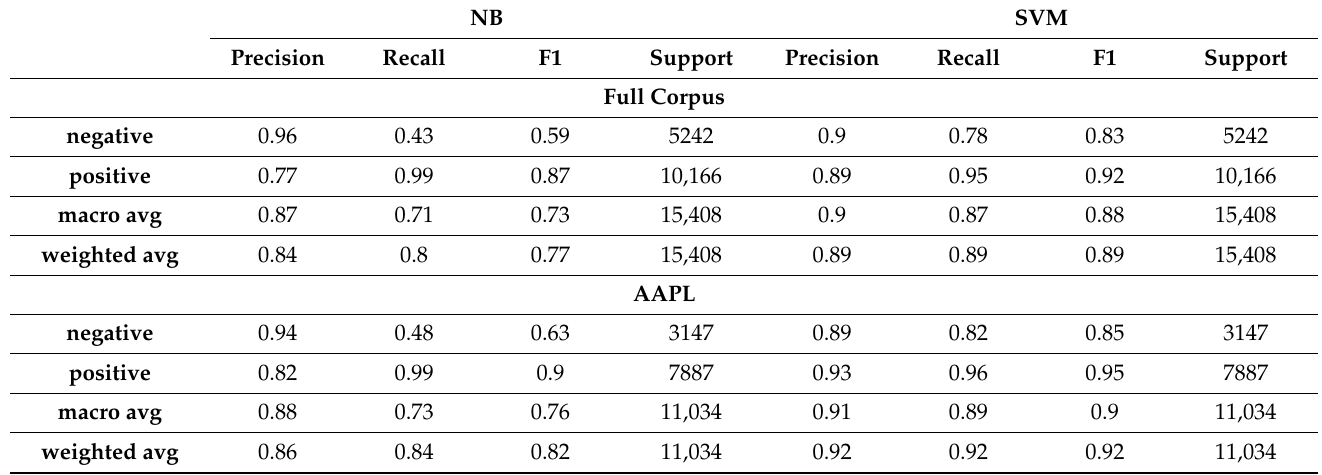
Table 7. Results of Classifiers Supervised Against Manual Sentiment. NB